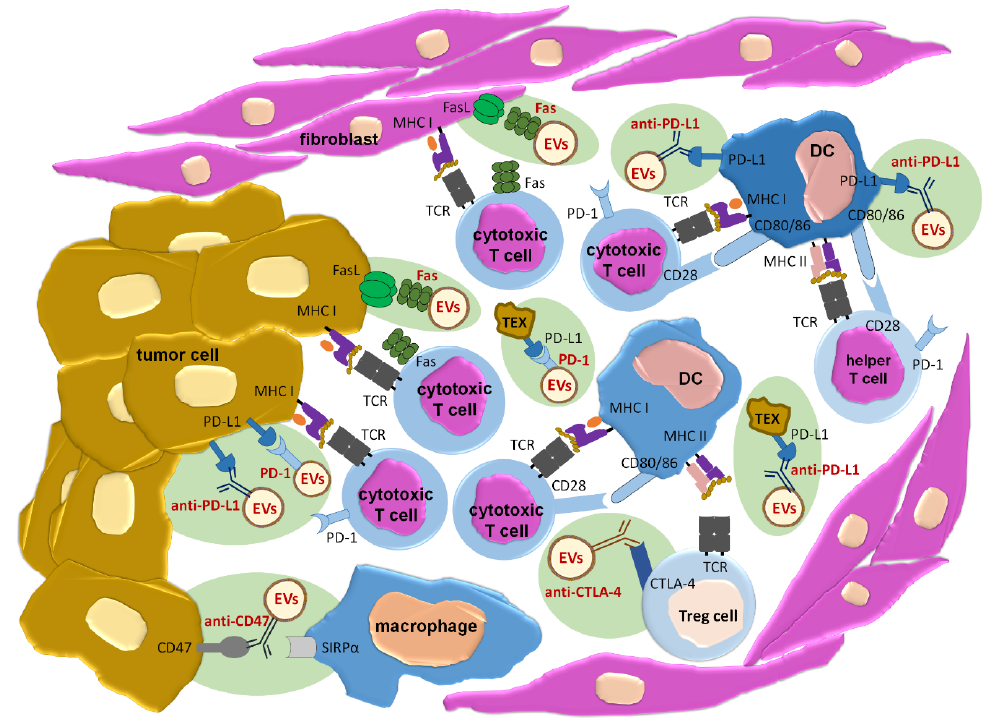
Figure 1. Perspectives in clinical application of extracellular vesicles (EVs) targeting the desired cell through receptor-ligand interaction or specific antibodies in prevention or restoration of immune tolerance to cancer. Sites of possible EVs’ action are additionally marked with a greenish background.